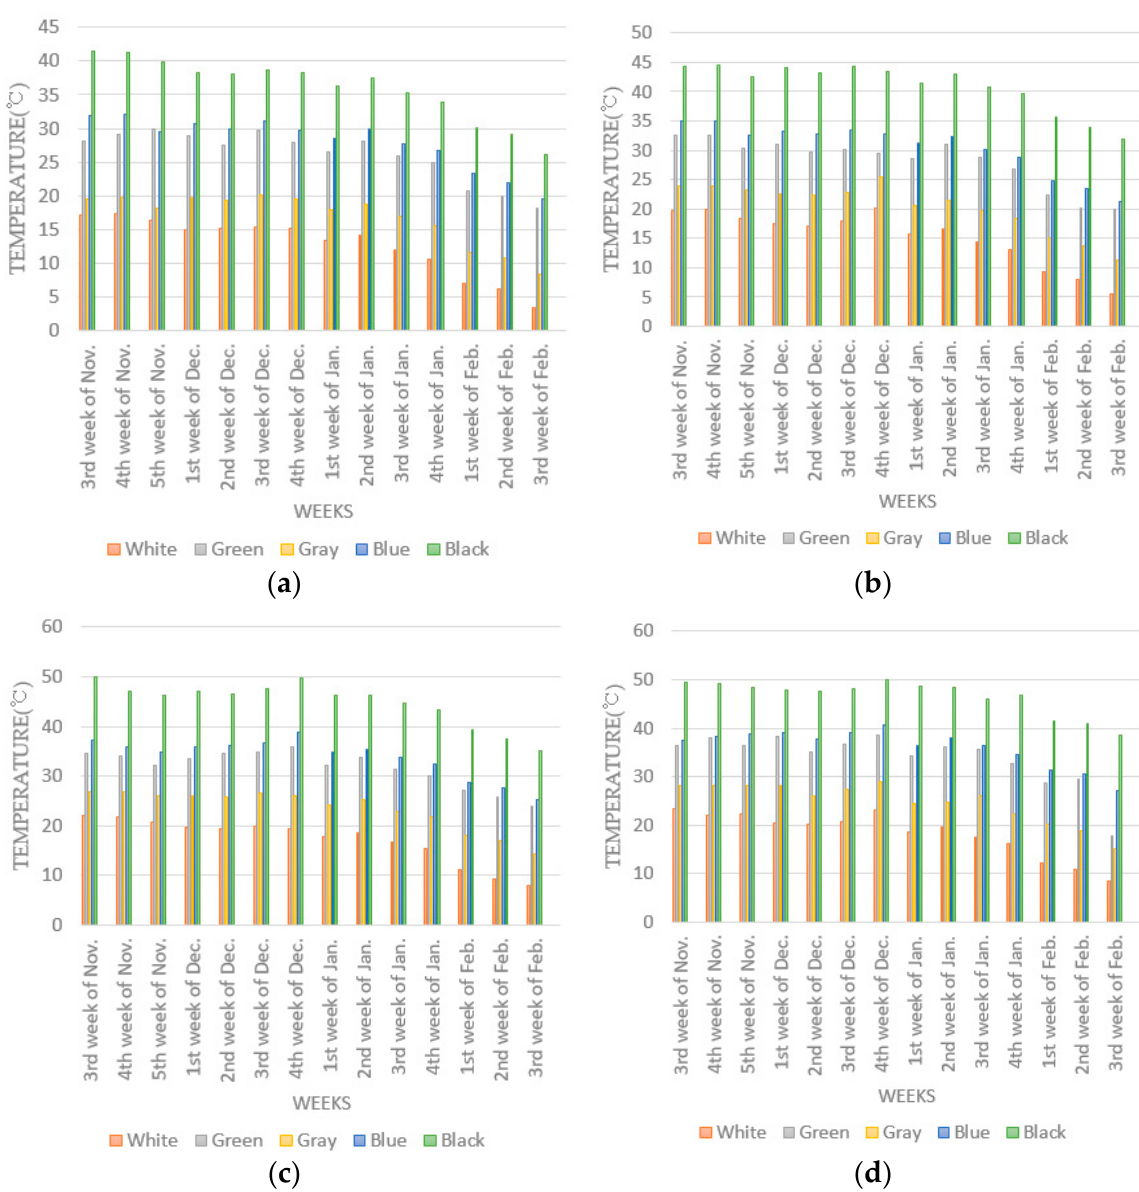
Figure 6. Weekly rooftop surface average temperatures acquired by a UAV-mounted TIR camera at different times (The vertical axis is the temperature ( °C ), and the horizontal axis is the weeks.): ( a ) 10h, ( b ) 12h, ( c ) 14h, and ( d ) 16h.